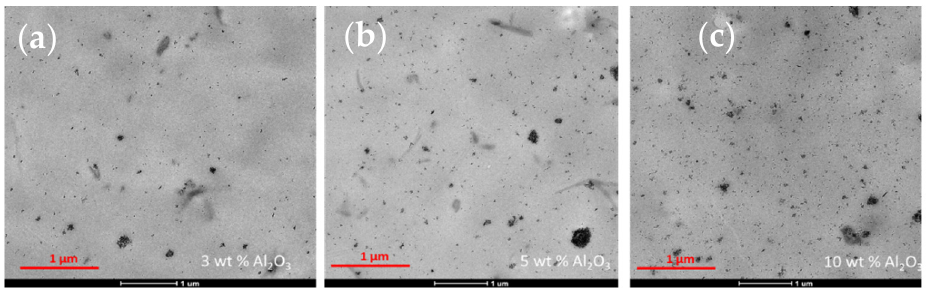
Figure 8. TEM micrographs for PHBH nanocomposites containing ( a ) 3 wt.%, ( b ) 5 wt.% and ( c ) 10 wt.% of alumina nanoparticles.